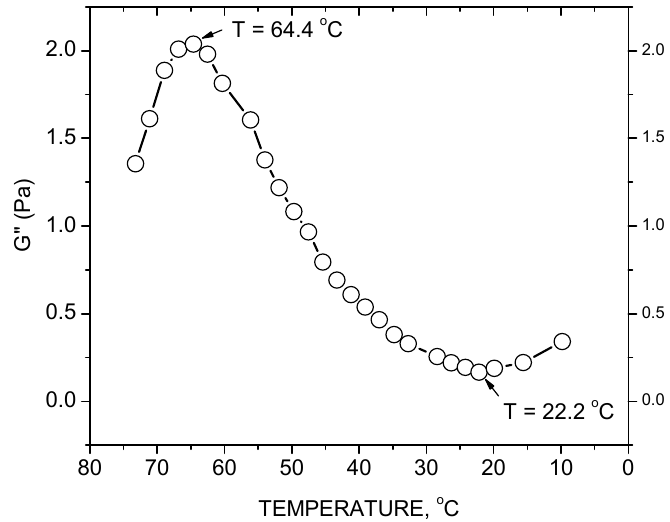
Figure 4. Rheological test for loss modulus (G”) of the molten gel upon cooling. The curve represents Figure 3. Rheological test for loss modulus (G ′′ ) of the molten gel upon cooling. The curve represents the variation of G” of the molten gel with cooling from 75 to 10 ◦ the variation of G ′′ of the molten gel with cooling from 75 to 10 °C.